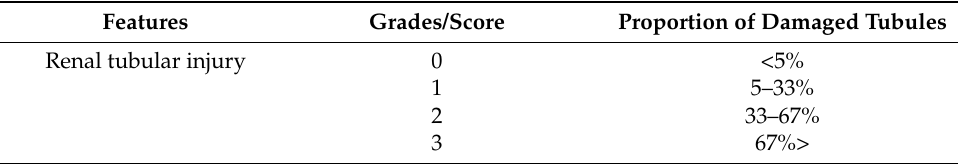
Table 1. Histopathological grading system for evaluating renal tubular injury in mice. Features Grades/Score Proportion of Damaged Tubules Renal tubular injury